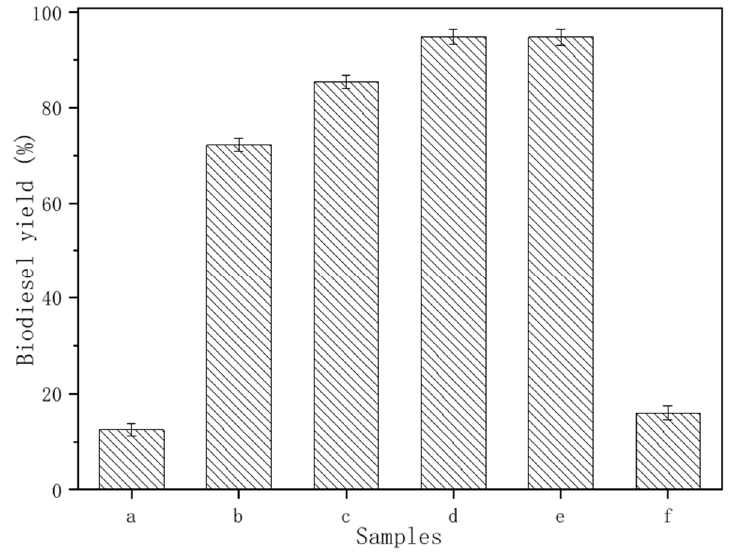
Figure 5. Biodiesel yield of different catalysts: (a) DN, (b) DN-250, (c) DN-300, (d) DN-350, (e) DN-400, and (f) PDN-350.